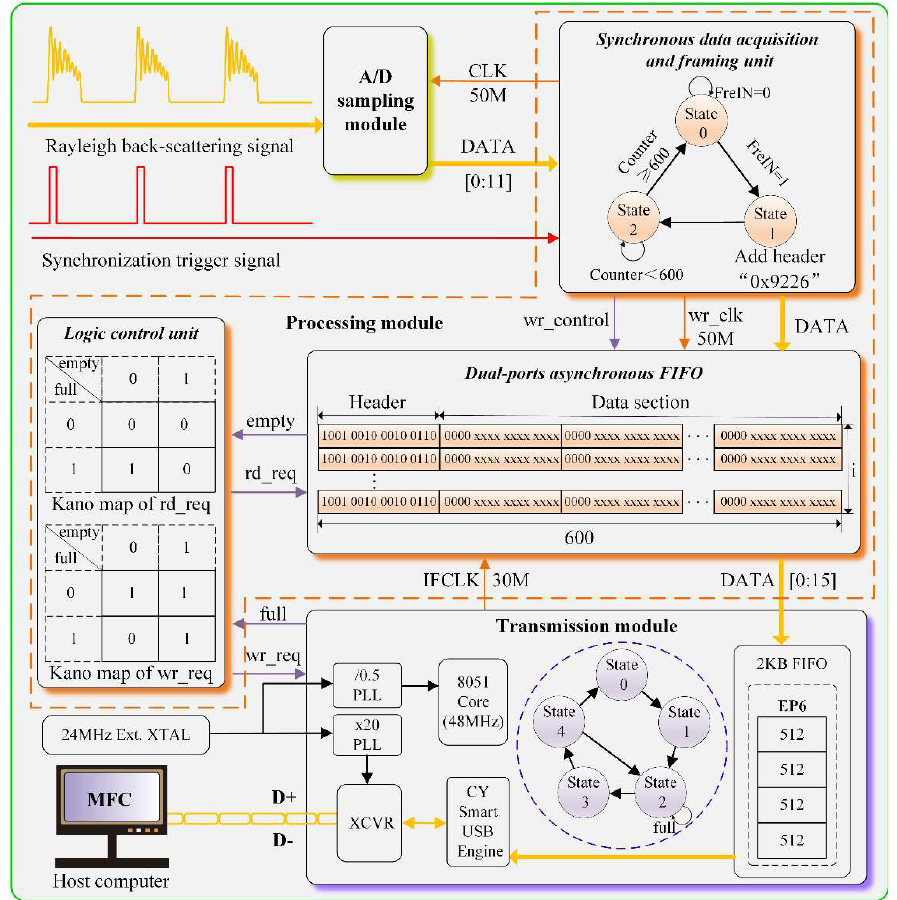
Figure 1. Overall block diagram of the hardware system.